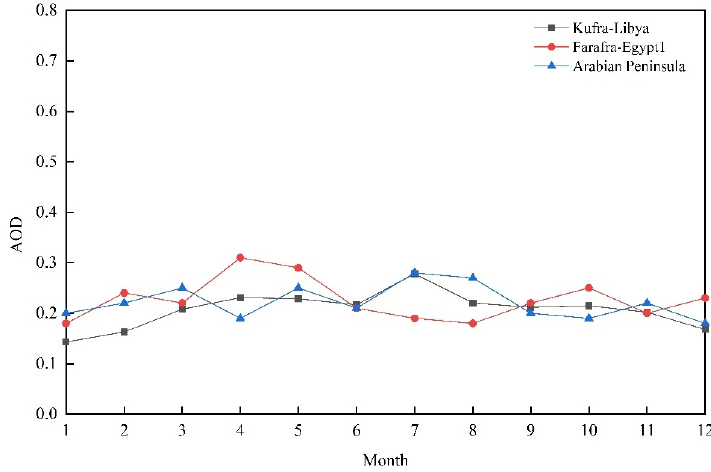
Figure 10. Monthly average statistics of aerosol optical thickness of three sites in 2018.